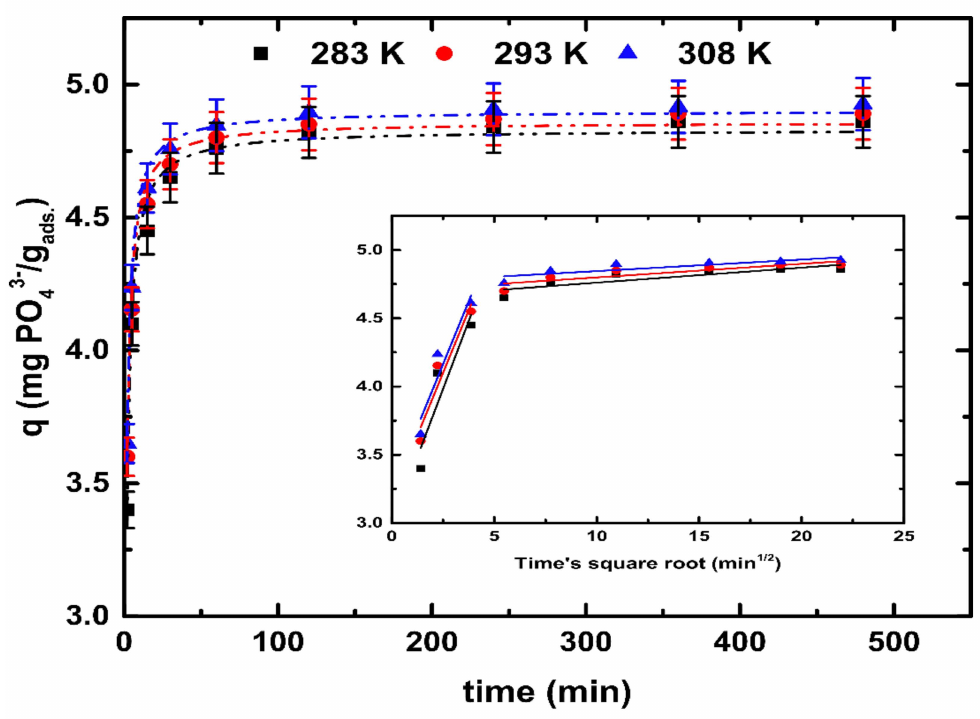
Figure 3. Kinetics data for the adsorption of phosphates onto schwertmannite in NSF water at pH 7 (C o : 10 mg PO 4 3 − /L, schwertmannite dose 200 mg/L). In the insert diagram of this figure, the results from the application of the parabolic diffusion law are